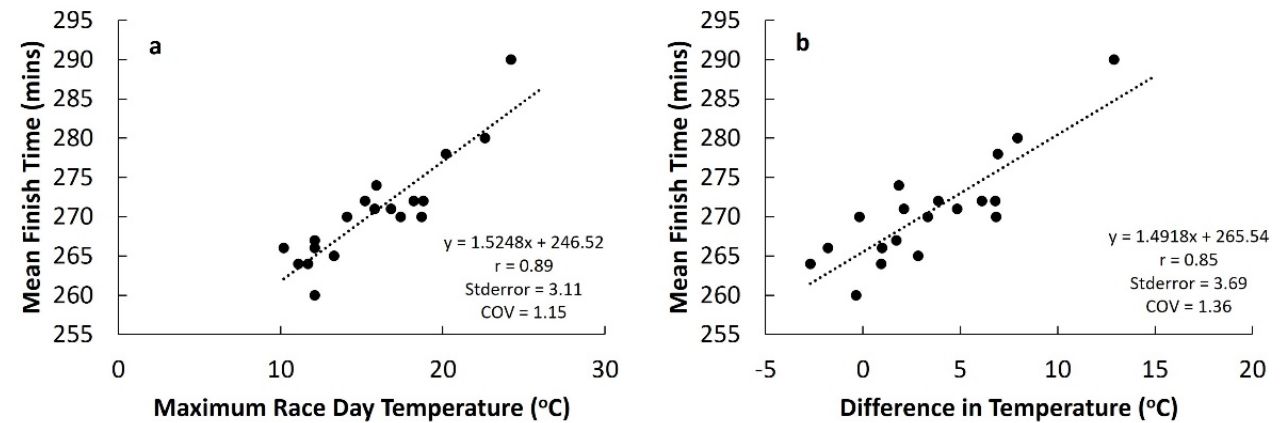
Figure 2. ( a ) Relationship between maximum race day temperature and mean finish time in the London Marathon 2001 to 2019. ( b ) Relationship between the difference in maximum race day temperature and maximum daily temperature during the 60 days prior to race day on mass participation and mean finish time in the London Marathon 2001 to 2019; stderror, standard error of the estimate; COV, coefficient of variation.